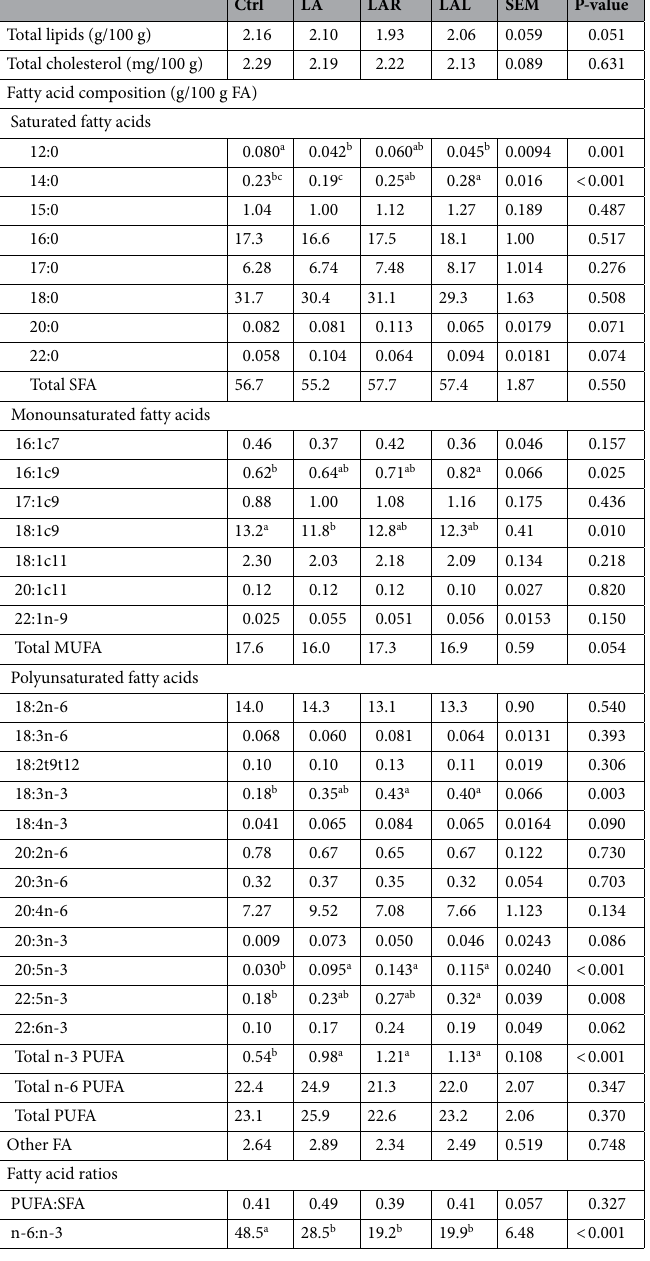
Table 2. Effect of diets on the hepatic fatty acid profile (g/100 g liver). Ctrl control diet, LA control + 10% Laminaria digitata , LAR LA + 0.005% Rovabio ® Excel AP, LAL LA + 0.01% alginate lyase. SEM standard error of the means. Values with different superscripts are significantly different at P <